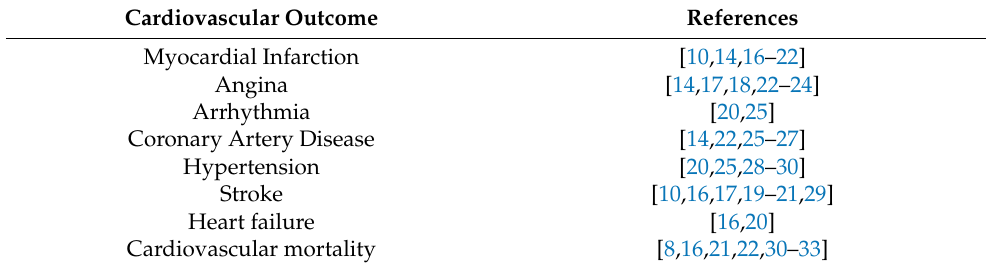
Table 1. Chronic pain-associated cardiovascular